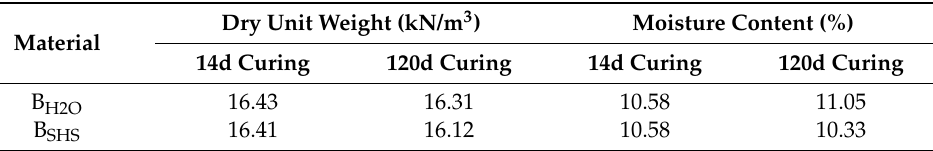
Table 4. Values of dry unit weight and moisture content for each experimental layer, determined during the molding